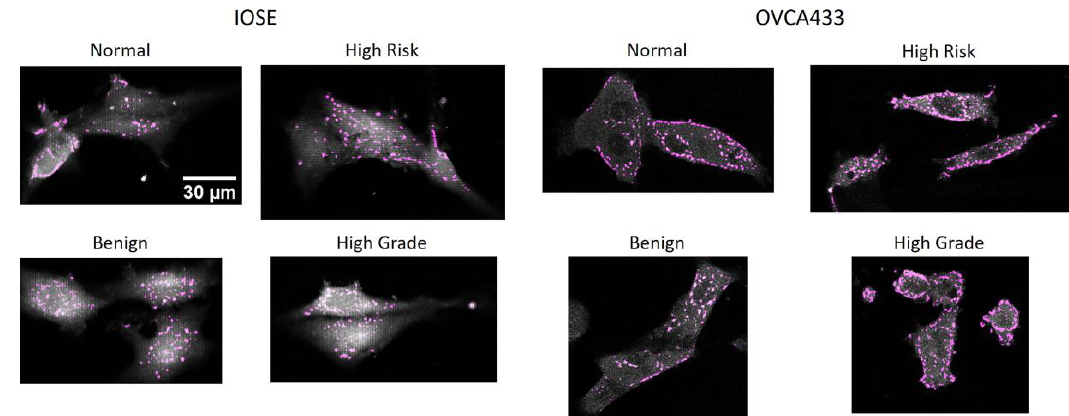
Figure 6. Representative two-photon excited immunofluorescence images of IOSE and OVCA433 cells stained with a primary anti-vinculin antibody and secondary antibody conjugated with Texas Red. Scale bar = 30 µm.